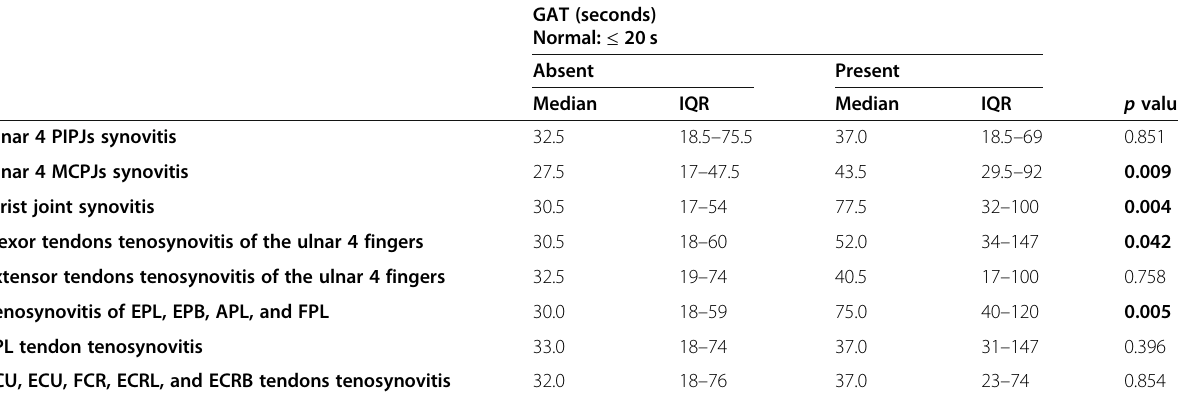
Table 2 Comparison between RA hands with and without different ultrasonographic findings as regards GAT. Cut-off values for 1 or more tenosynovitis of any of the mentioned